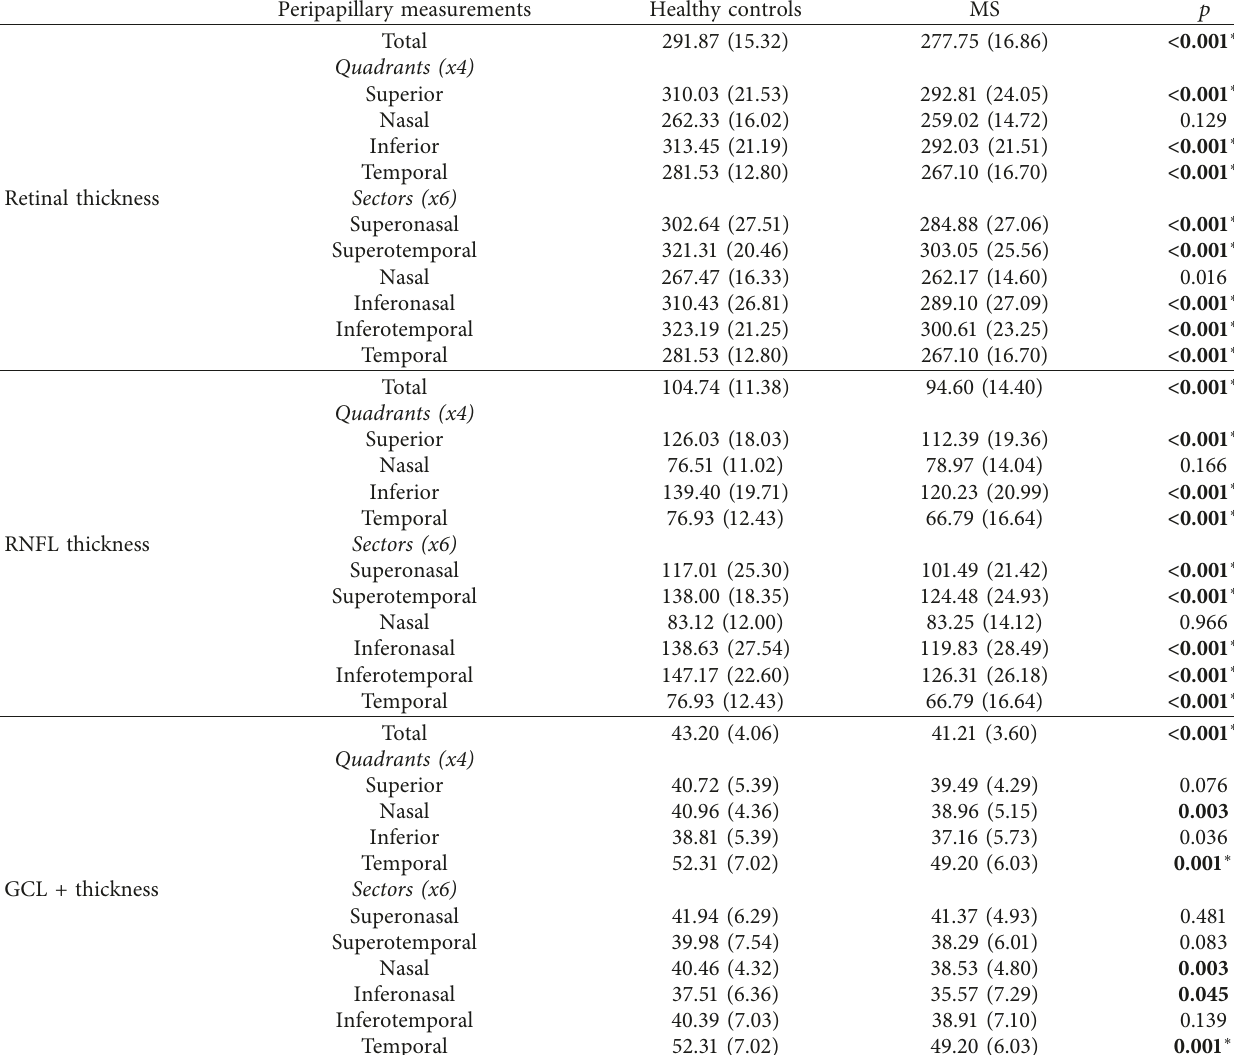
Table 2: Peripapillary retinal and ganglion cell layer thickness as measured with swept-source deep range imaging optical coherence tomography Triton in patients with multiple sclerosis and healthy